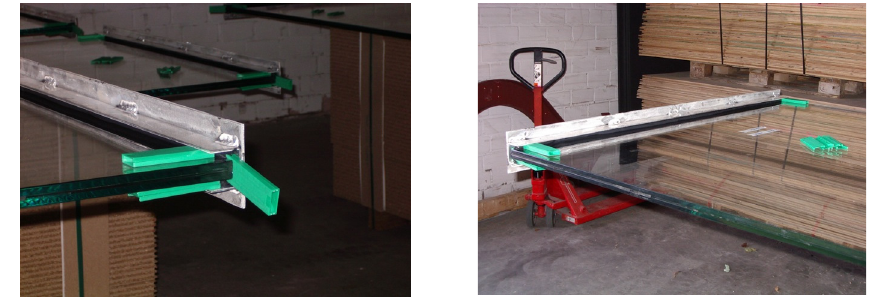
Figure 7: Adhering aluminum profile to glass panes.